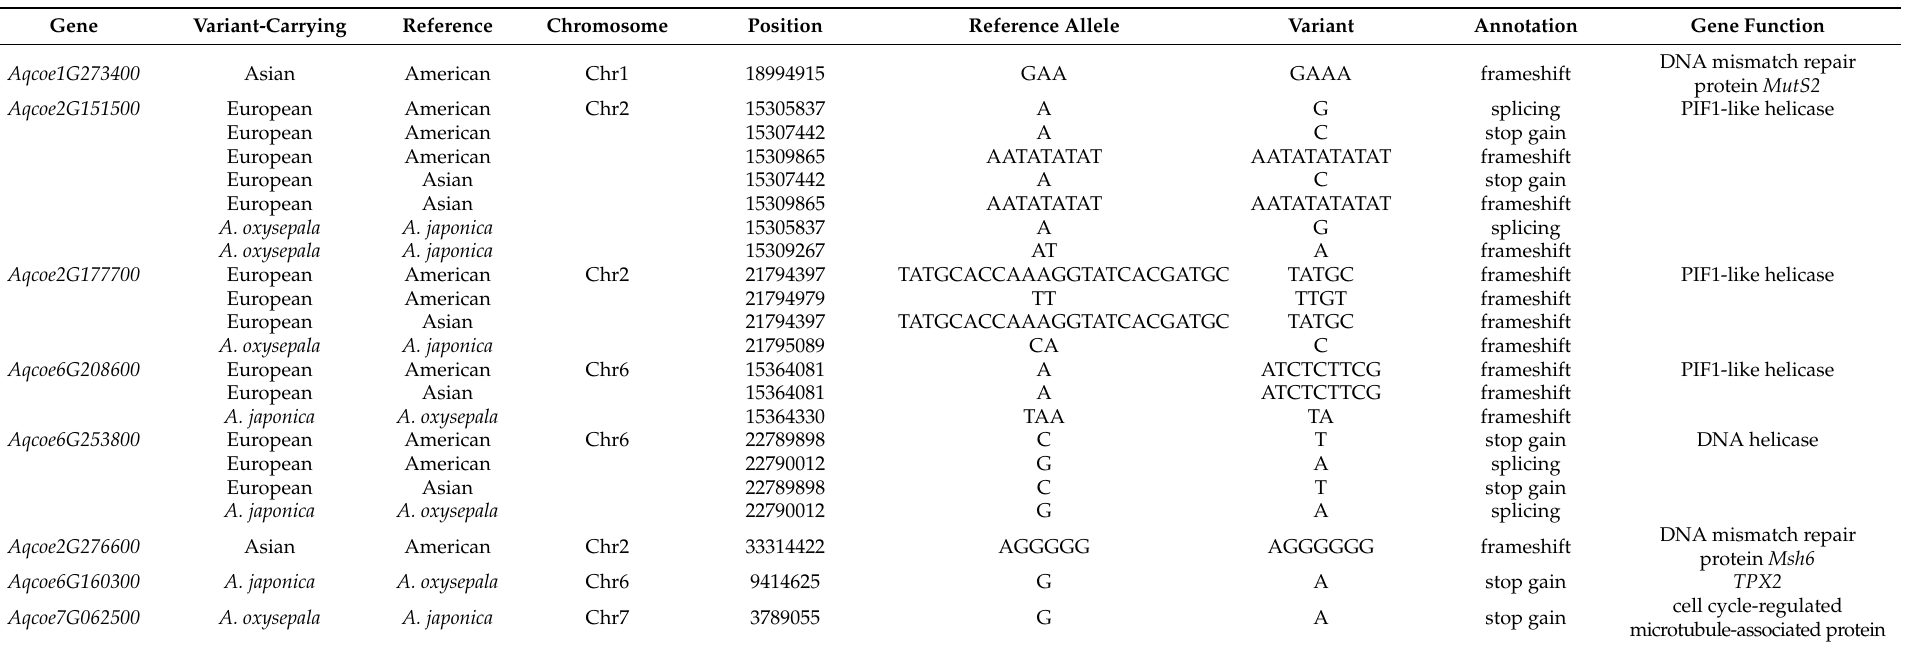
Table 1. Information of the high-impact conservative clade-specific variants (CCVs) in the cell reproduction related genes.